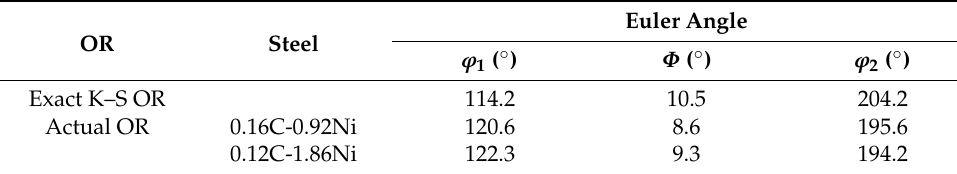
Table 3. Orientation relationship (OR) of two steels at 0.5 ◦ C/s cooling rate.